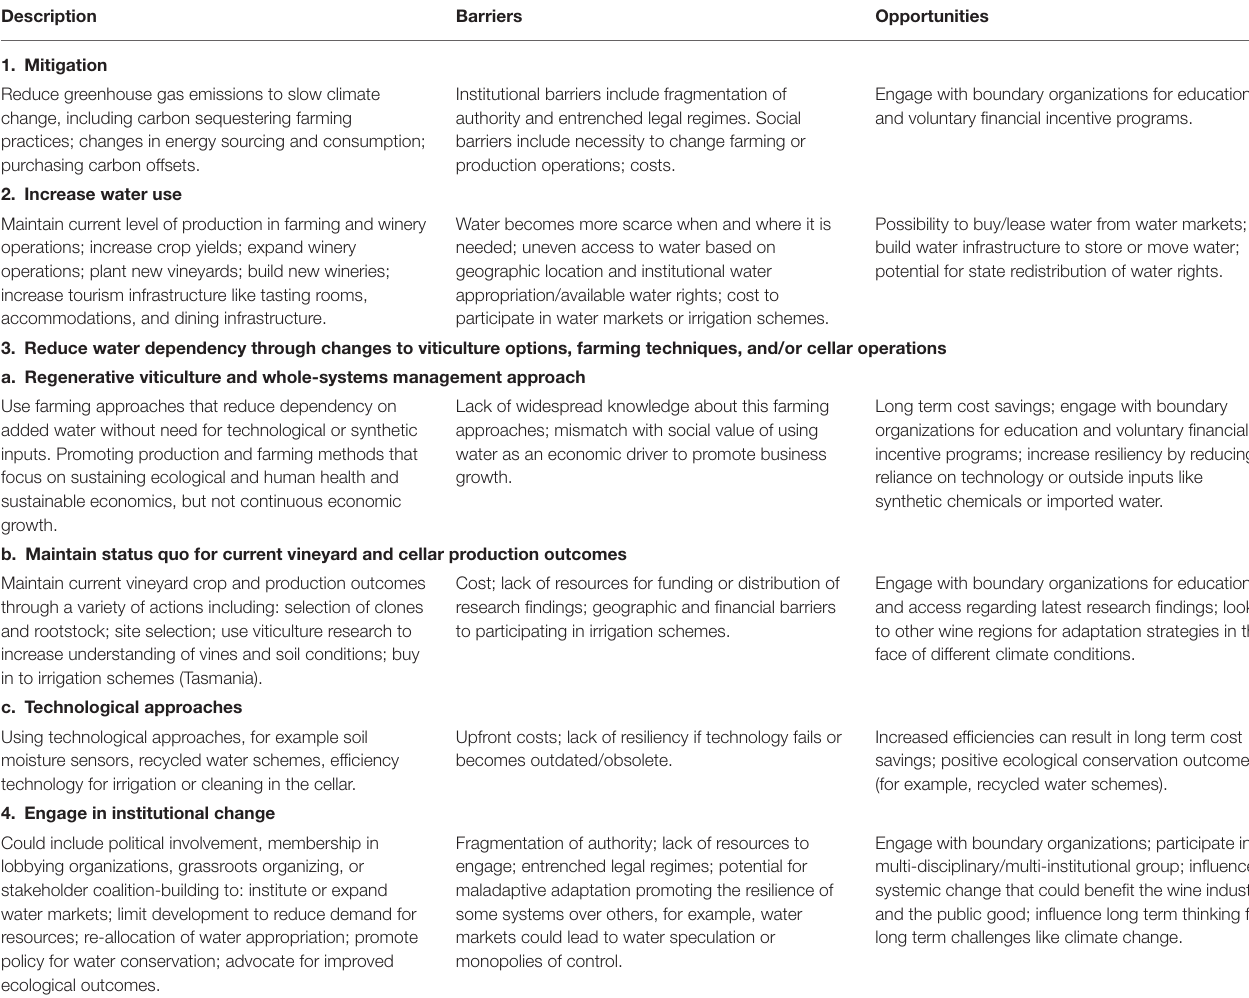
TABLE 3 | Wine industry water resource adaptation